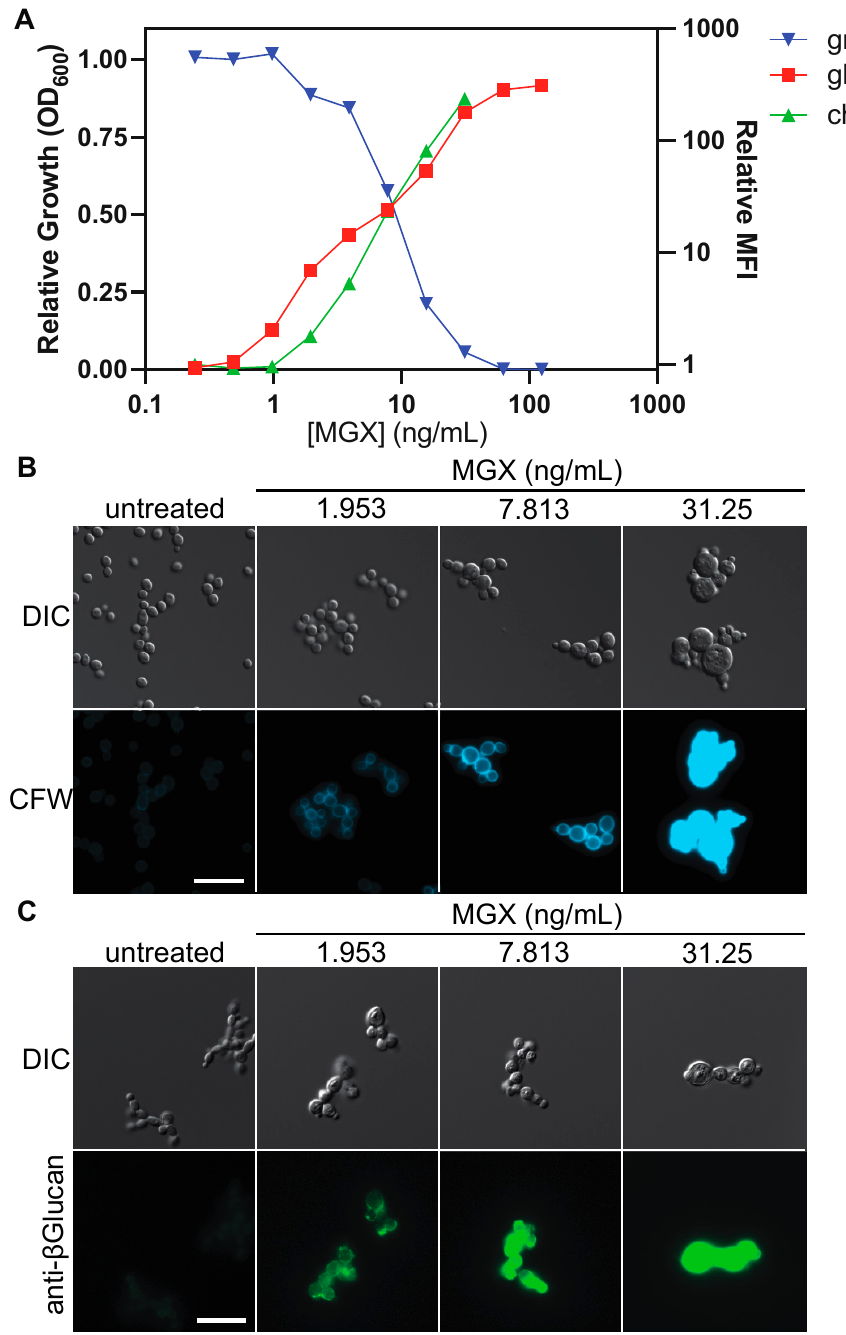
Figure 4. MGX treatment increases chitin levels and exposes (1 → 3)- β -D-glucan at the fungal cell surface. ( A ) C. albicans was grown in YPD supplemented with MGX for 24 h at 30 °C then growth was measured by optical density. Left: Mean relative growth for duplicate wells from a repre- sentative experiment. Cells were formaldehyde fixed, then stained with CFW or labelled with a mouse monoclonal antibody to (1 → 3)- β -D-glucan and goat anti-mouse secondary antibody con- jugated to AlexaFluor488 and examined by flow cytometry. Right: Median fluorescence intensity for CFW and AlexaFluor488 labelled cells normalized to untreated controls (>20,000 events/sample). Fluorescence intensity for CFW staining saturated the flow cytometer at [MGX] > 31.25 ng/mL. ( B ) Representative fluorescence micrographs of CFW-stained C. albicans (blue) pre- pared as in A. Scale bar, 20 µm. ( C ) Representative (1 → 3)- β -D-glucan immunofluorescence (green) micrographs of C. albicans prepared as in A. Scale bar, 20 µm.